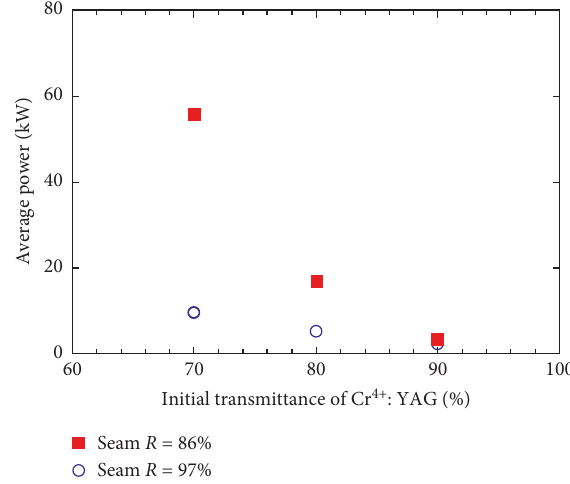
Figure 8: Average output laser power per single Q-switched and self-mode-locked laser pulse for initial transmittance of Cr 4+